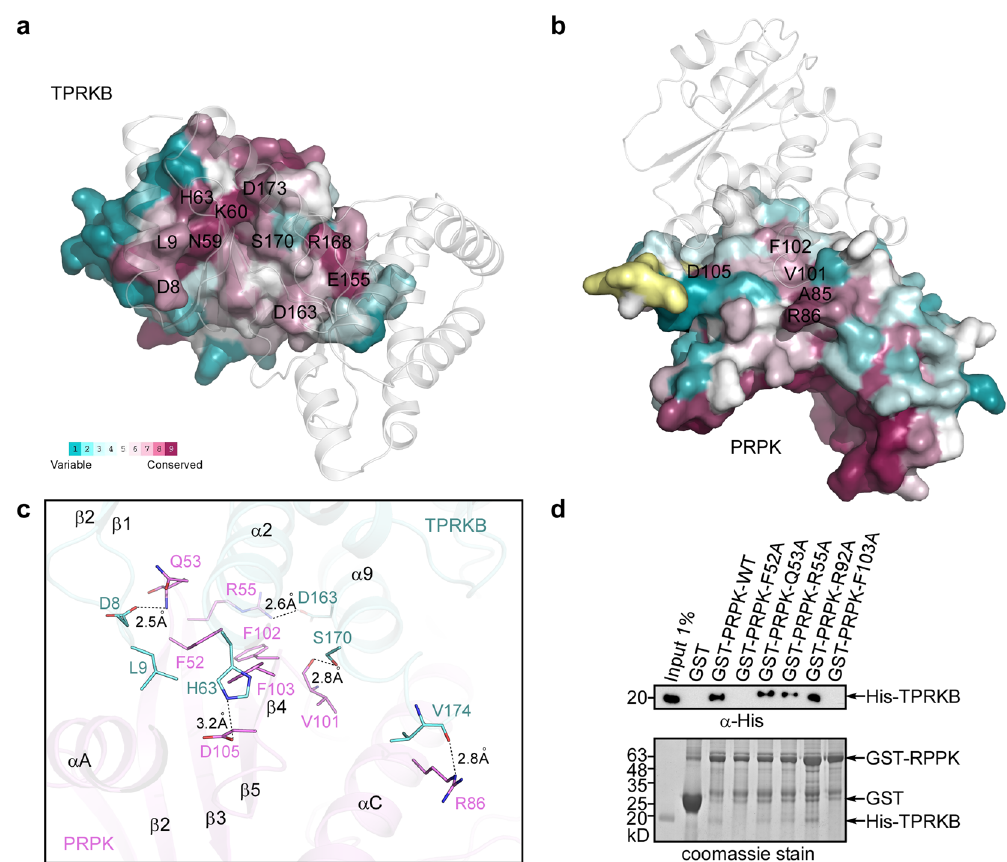
Fig. 4 Interaction between PRPK and TPRKB. a ConSurf style representation of the TPRKB surface involved in PRPK interaction. PRPK is shown as semi- transparent cartoon in white color. b ConSurf style representation of the PRPK surface involved in TPRKB interaction. TPRKB is shown as semi-transparent cartoon in white color. c Detailed interaction between PRPK and TPRKB. PRPK F52, F102, and F103 constitute a hydrophobic surface hosting the TPRKB helix α 2. Hydrogen bonds are formed between PRPK Q53 and TPRKB D8, between PRPK R86 and TPRKB V174, and lastly between PRPK V101 and TPRKB S170 (dashed lines). Salt bridges link PRPK R55 with TPRKB D163, and link PRPK D105 with TPRKB H63 (dashed lines). d Pulldown of His-tagged TPRKB by GST-tagged PRPK mutants. GST-tagged PRPK was fi rst immobilized on glutathione Sepharose beads and then incubated with a puri fi ed His-tagged TPRKB protein. After extensive washing, His-TPRKB bound to PRPK was detected using a His antibody. A representative result from at least three repetitions is shown. Uncropped images of gel and blot are shown in Supplementary Fig.